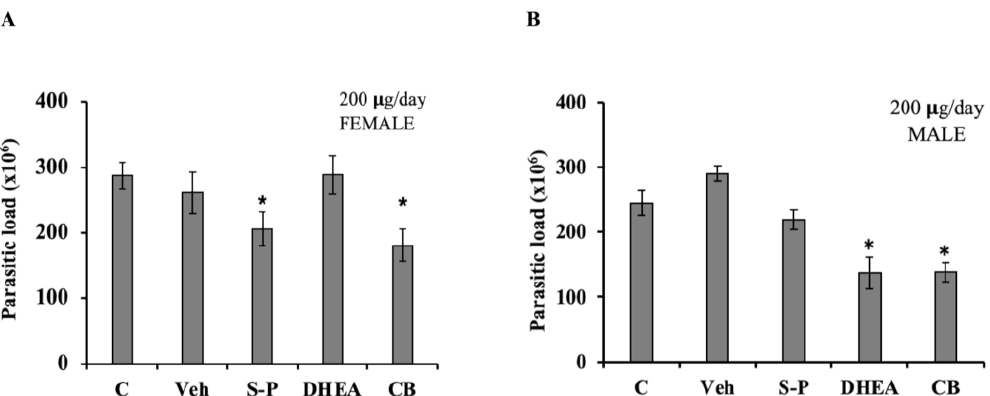
Figure 7. Effect of DHEA in acute infection of Toxoplasma gondii . Mice previously infected with tachyzoites of T. gondii were administered with 200 µ g/day of DHEA or S/P or 200 µ g/day of DHEA/S-P. ( A ) Female mice and ( B ) Male mice; the y -axis shows the parasite load obtained in the intraperitoneal exudate. (*) showed the statistical significance compared to untreated group. C, control (untreated mice), Veh, corn oil was used as vehicle; CB, combined treatment. p <